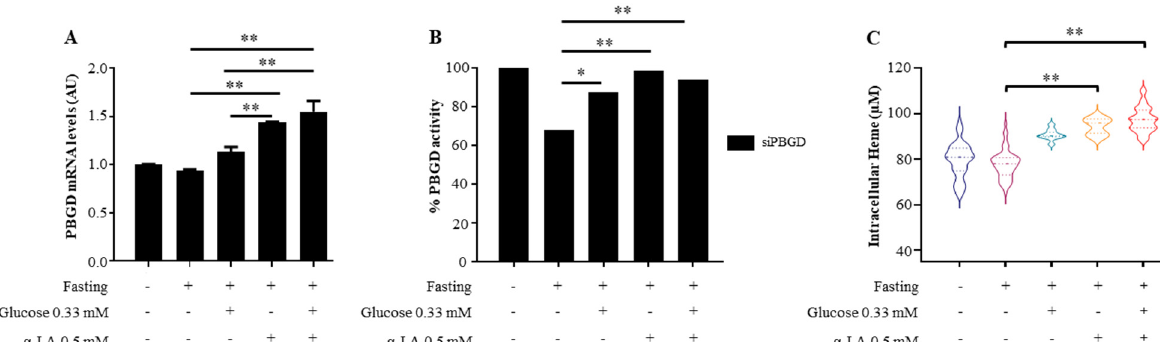
Figure 1. α -LA rescued heme biosynthesis in PBGD-silenced HepG2 cells. ( A ) The mRNA expression of PBGD was evaluated by qRT-PCR in siPBGD cells at baseline, after fasting and in the presence of glucose, α -LA, or both treatments. ( B ) The percentage of PBGD residual activity was assessed in siPBGD cells at baseline, after fasting and in the presence of glucose, α -LA, or both treatments. ( C ) Heme concentration (µM) was determined in siPBGD cells and compared to fasting, siPBGD + Gluc, siPBGD + α -LA, and to siPBGD plus α -LA + Gluc. For gene expression, data were normalized to the ACTB housekeeping gene and expressed as fold increase (Arbitrary Unit—AU) compared to the control group. For violin plot, data were expressed as median concentration (thick dashed lines) and interquartile range (dotted lines). At least three independent experiments were conducted. Adjusted * p < 0.05 and ** p < 0.01.